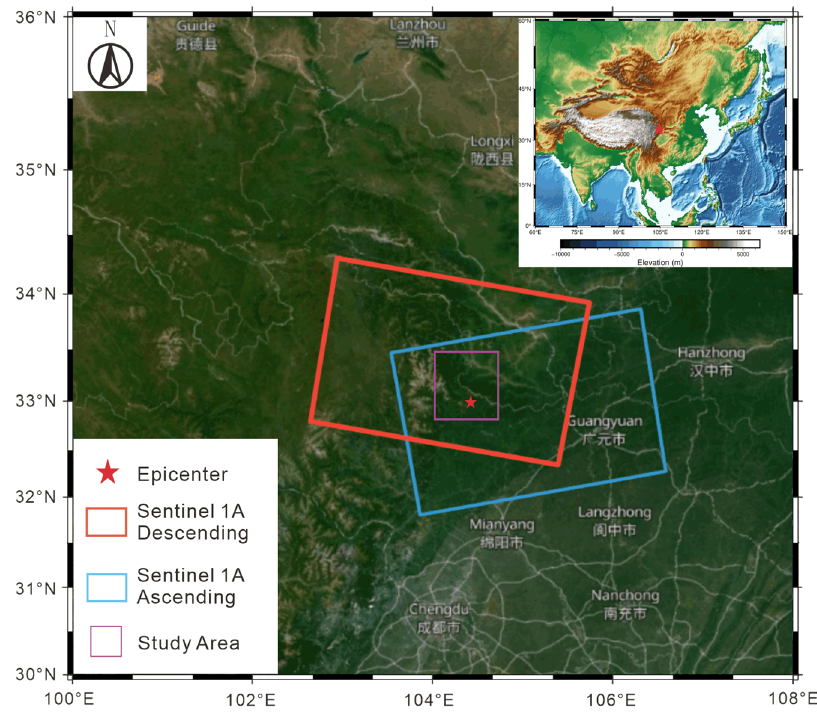
Figure 1. The location of the study area and coverage areas of SAR datasets.